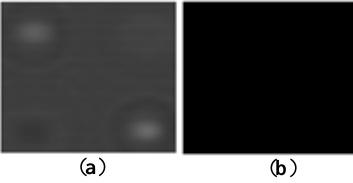
Figure 12. Microwave image of the sample for the composite material: ( a ) magnitude and ( b ) phase.